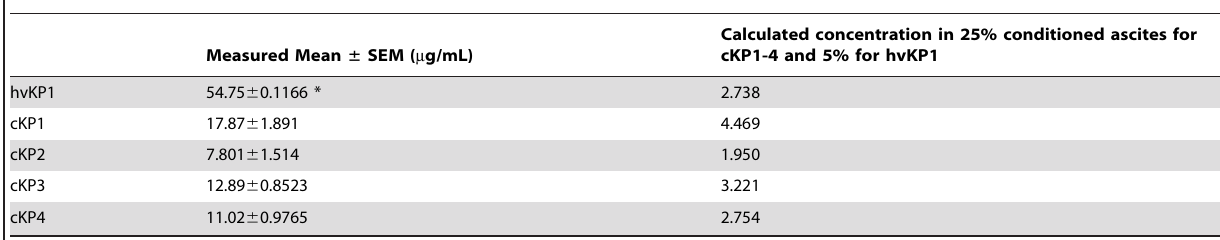
Table 1. Siderophore concentration in hvKP1 and cKP1-4 generated conditioned ascites.